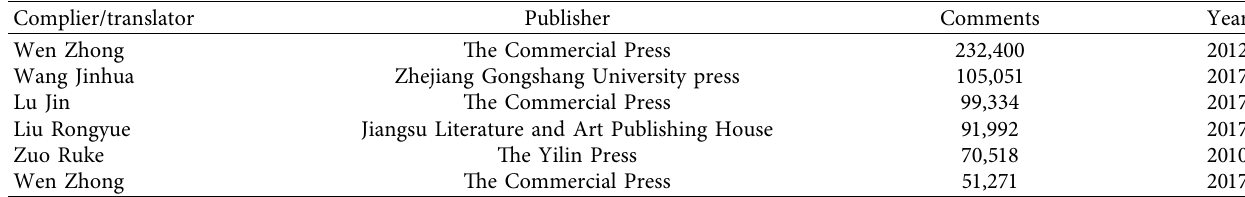
Table 6: Bestseller of Robinson Crusoe in Dangdang.